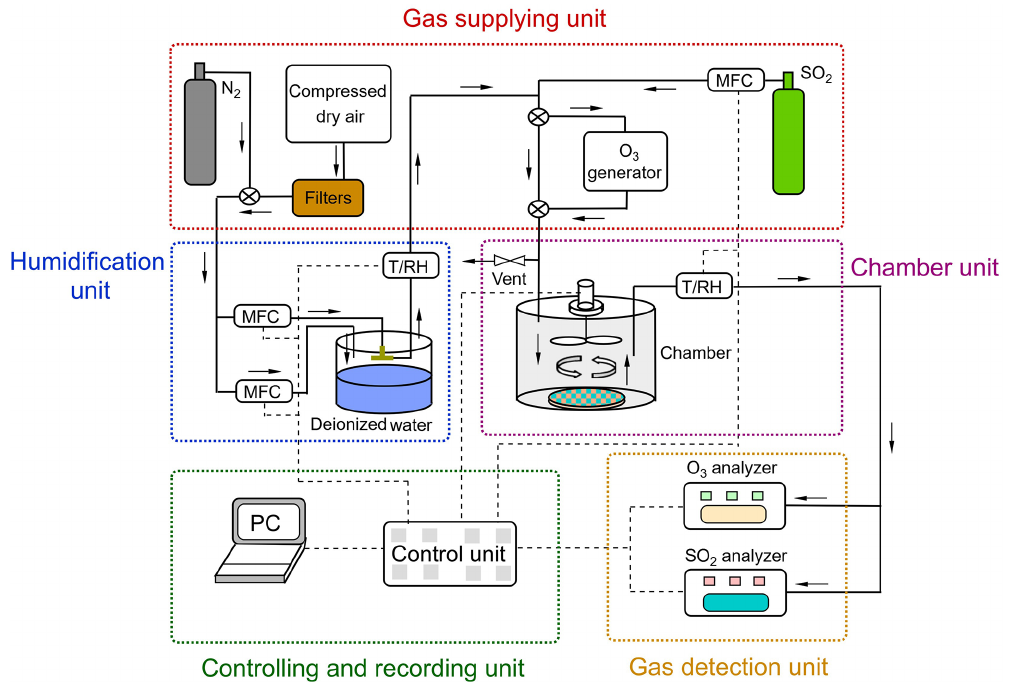
Figure 2. Schematic of the chamber system. The N 2 was only used to pre-condition the prepared samples at different RH and the filtered compressed air was used for uptake experiments.